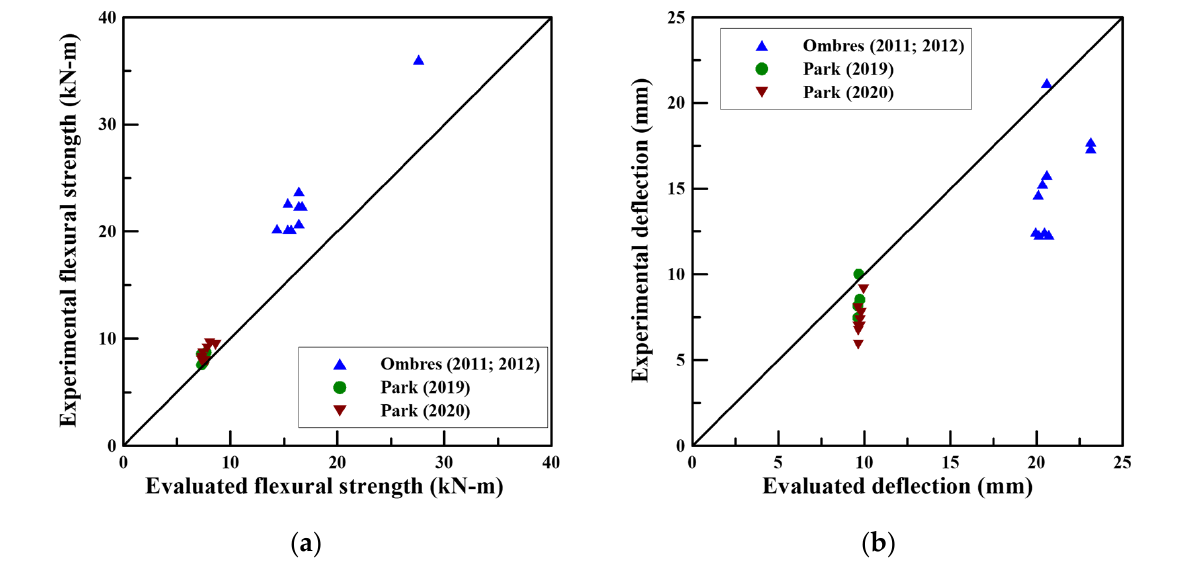
Figure 5. Comparison of experimental and evaluated results: ( a ) Flexural strength; ( b ) Deflection. Table 9. Comparison of experimental and evaluated results at the service load stage. Table 8. Failure mode, flexural strength, and deflection of each reference.